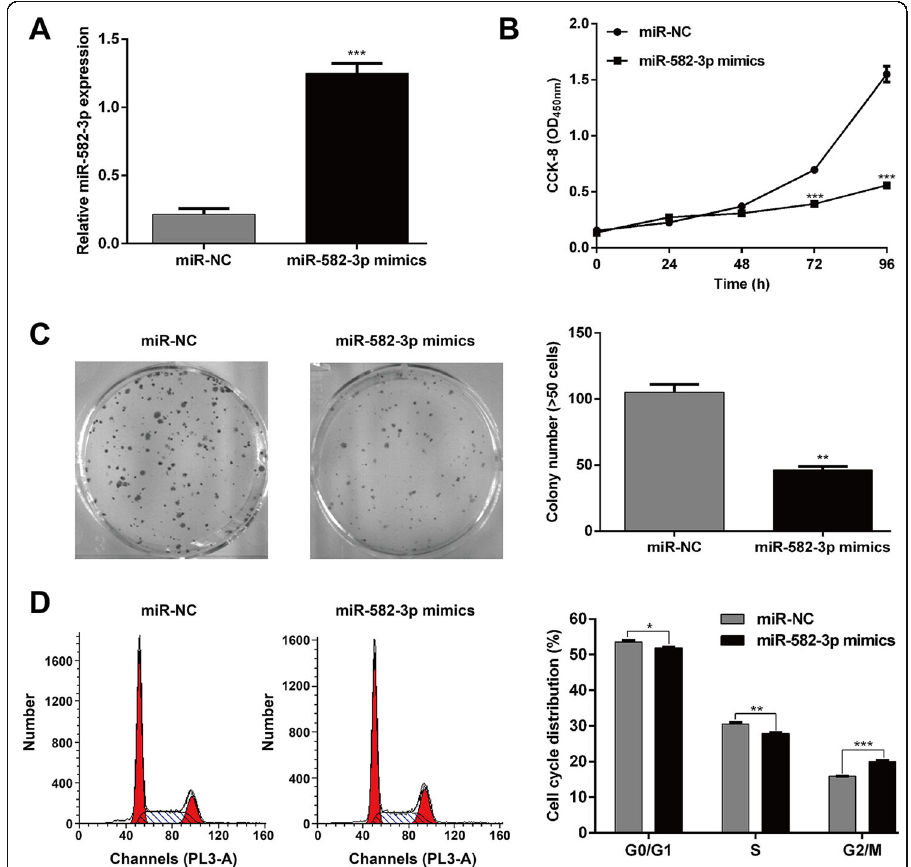
Fig. 2 Effects of miR-582 – 3p overexpression on cell proliferation and cell cycle progression in AML cells. THP-1 cells were transfected with miR-582 – 3p mimics or miR-NC. a The expression of miR-582 – 3p was